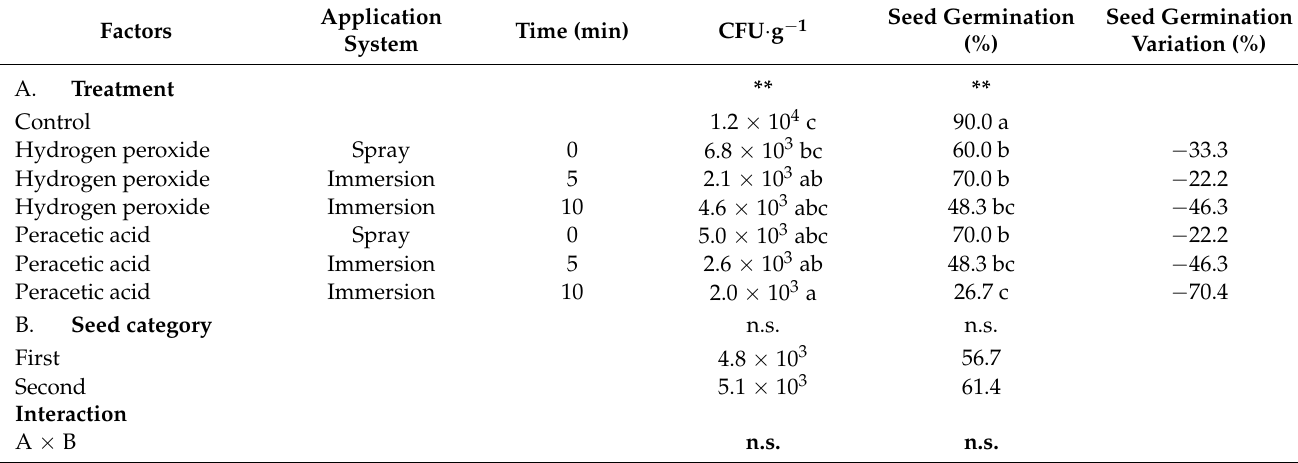
Table 6. Analysis of variance of CFU · g − 1 and seed germination (%) at the end of the in vivo trial with chemical disinfectants. 0.3% of hydrogen peroxide or 0.3% of peracetic acid were applied to garlic cloves divided in the two quality categories (first category cloves length > 15 mm, second category 10–15 mm clove length). Two different application systems were tested (spray and immersion). Different letters indicate significant differences according to Tukey’s test ( p < 0.01).